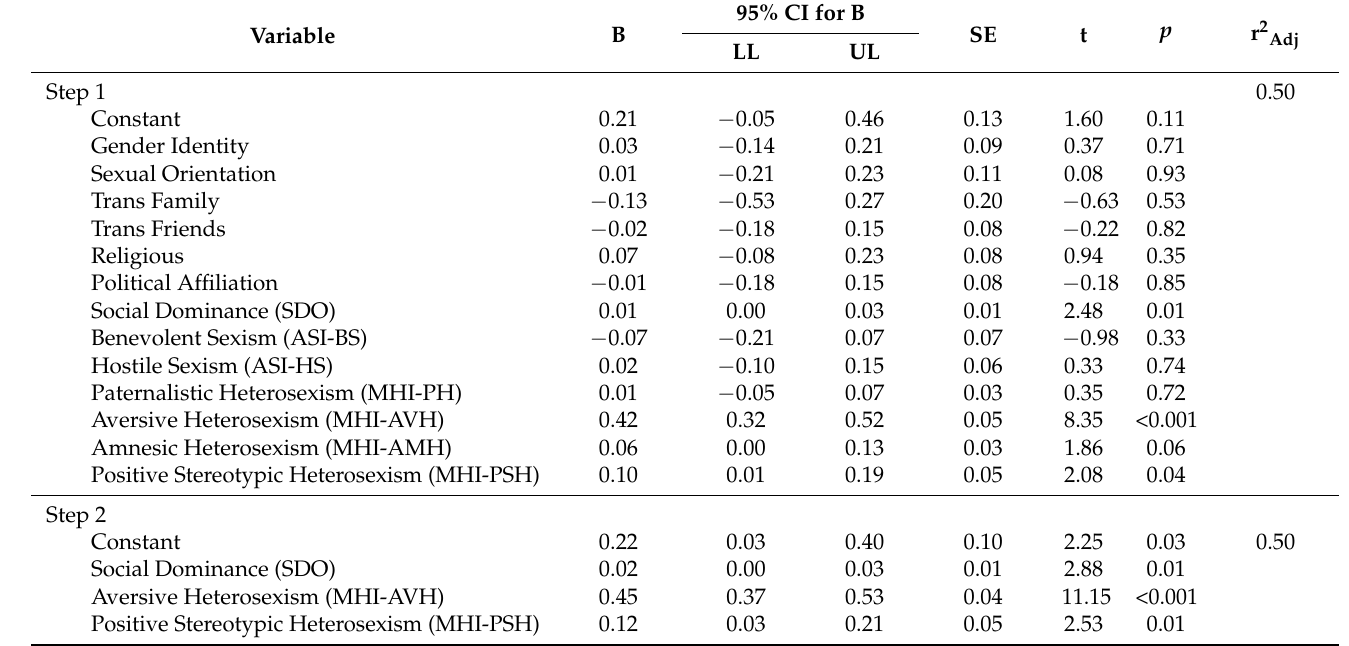
Table 6. Regression Coefficients for